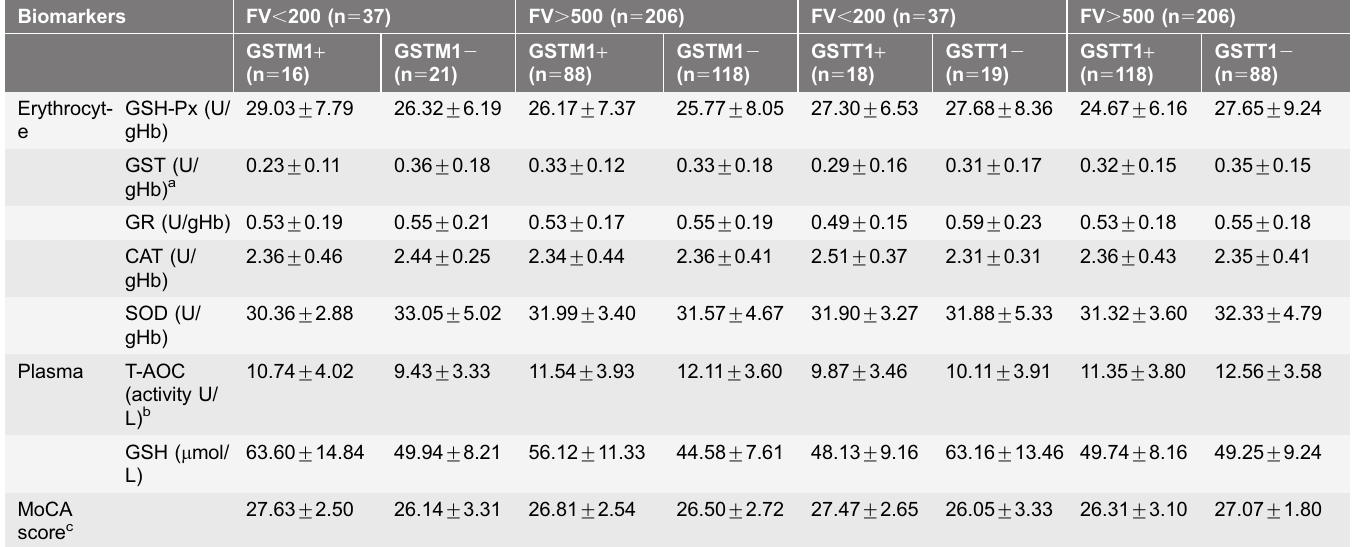
Table 4. Antioxidant parameters and cognitive function according to FV consumption and individual GST genotype.